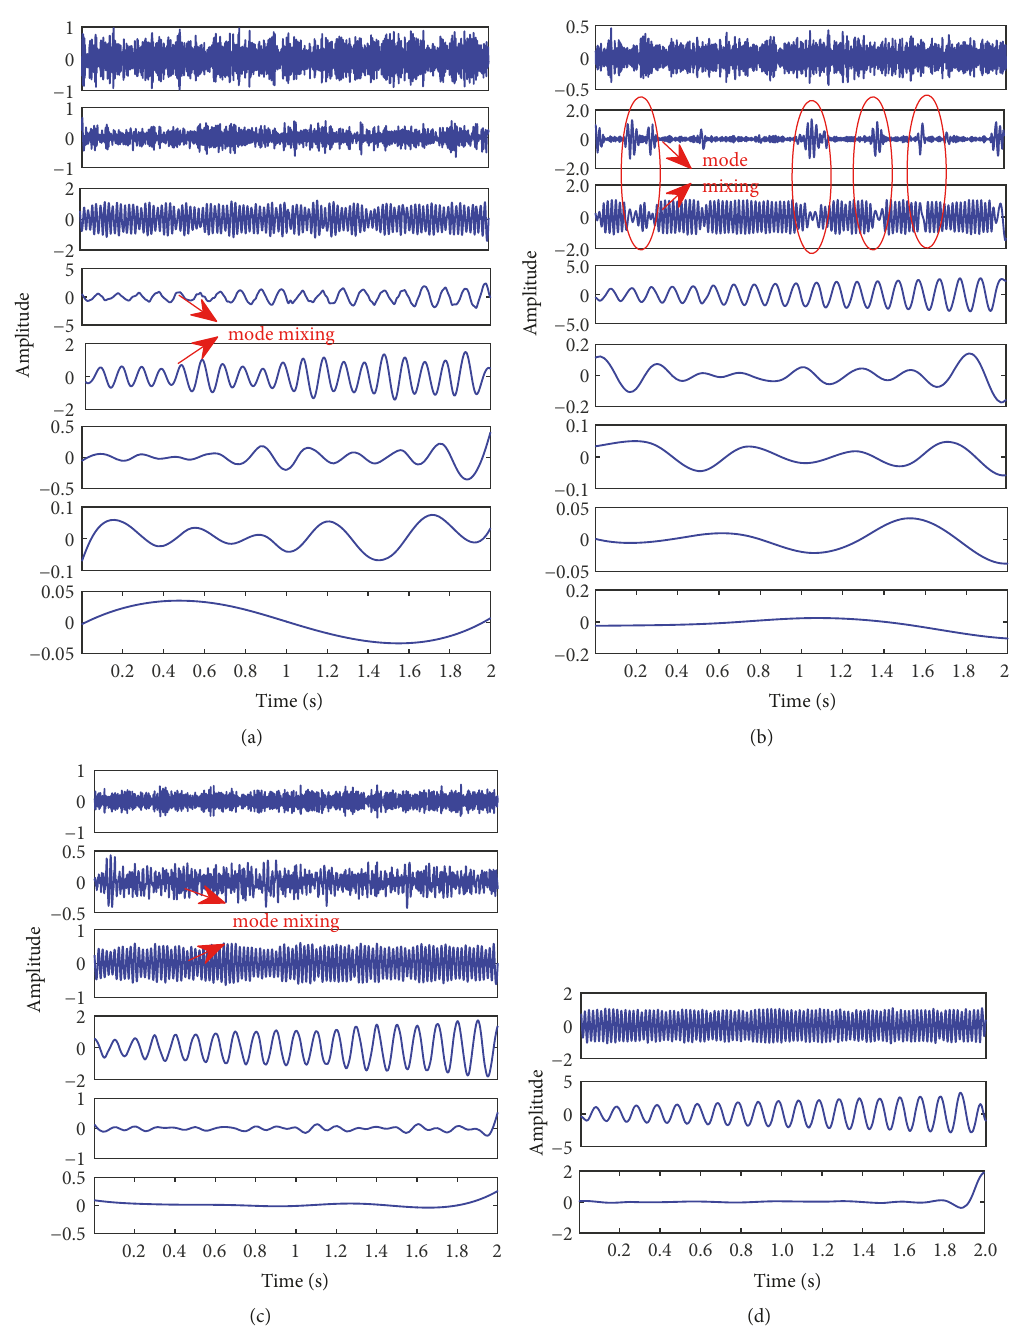
Figure 13: Decomposition results obtained by LMD (a), ELMD (b), CELMD (c), and improved ELMD (d).